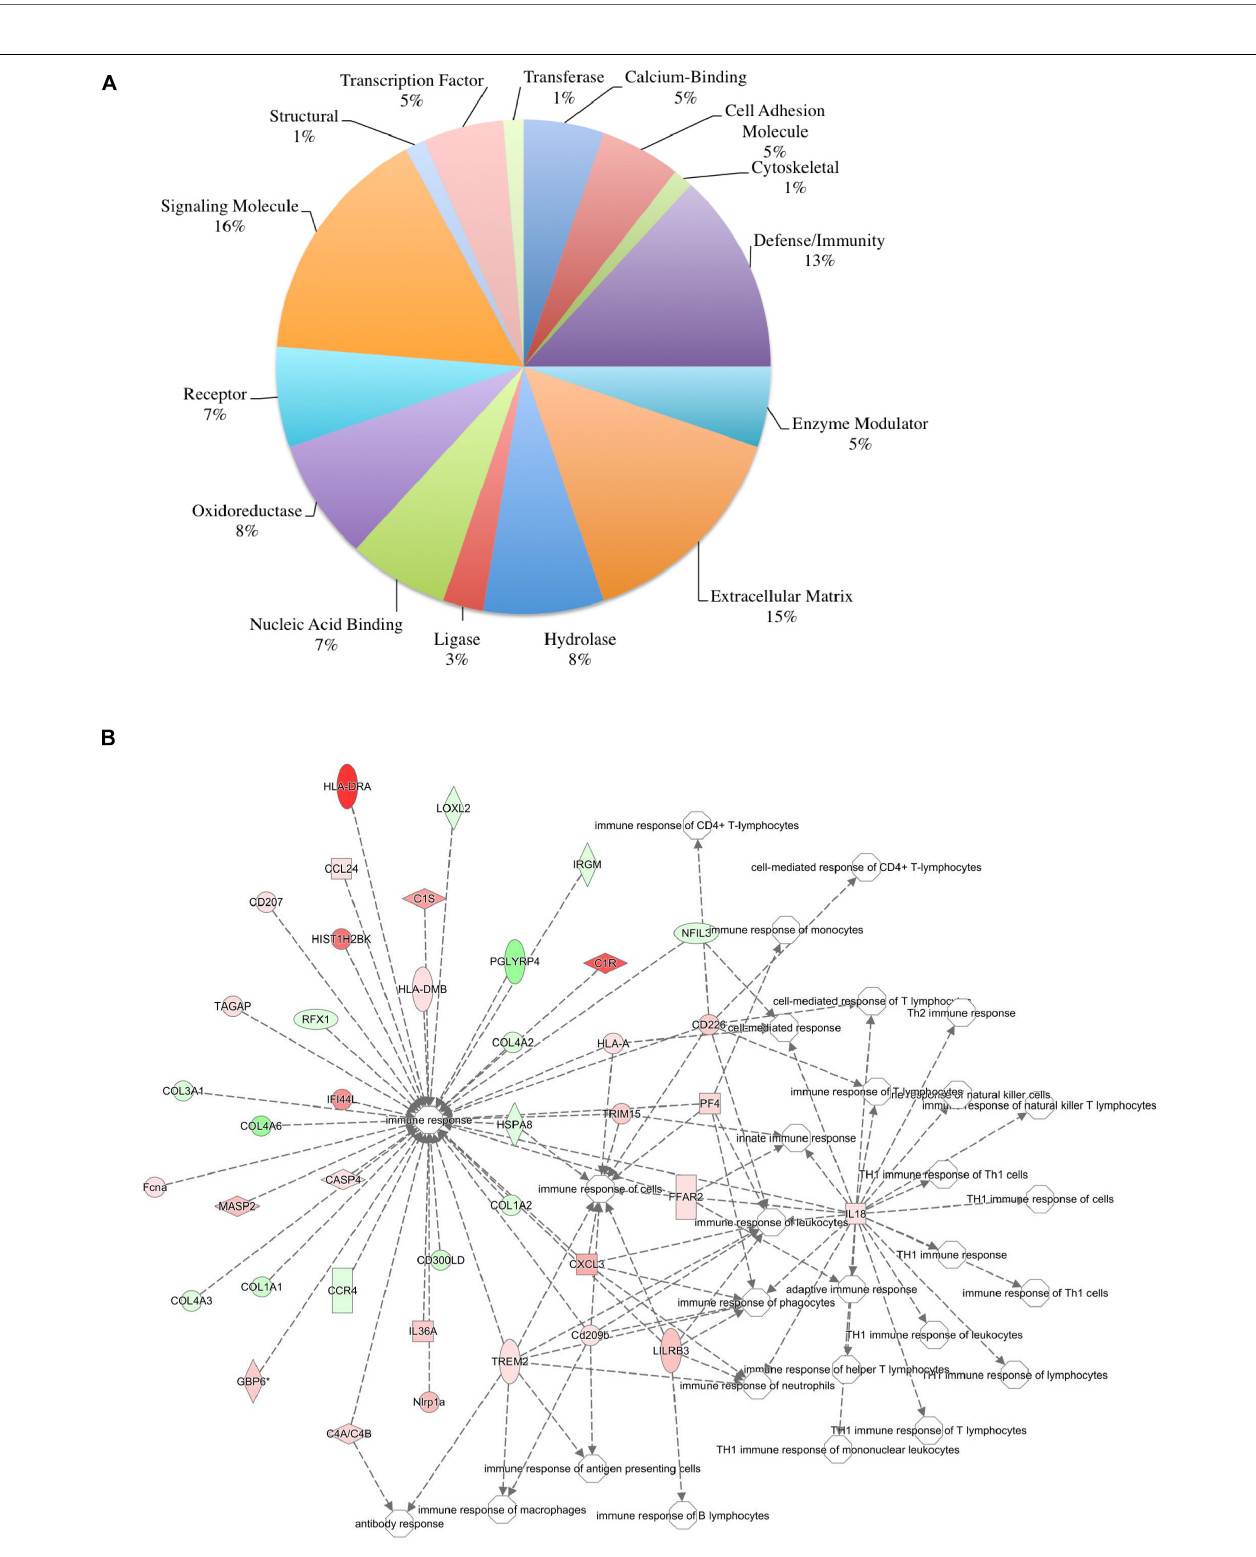
FIGURE 4 | Overall immune response-associated transcriptional changes observed in BALB/c versus C57BL/6 normal skin. Total RNA was isolated from untreated BALB/c and C57 skin samples and subjected to transcriptome analysis by MiSeq. Differential gene lists were created with two-fold expression cutoff and significant FDR of < 0.1 ( n = 6/experimental group). (A) PANTHER protein class pie chart of all genes significantly modulated. (B) IPA network association of all genes significantly modulated with a known immune-associated function.